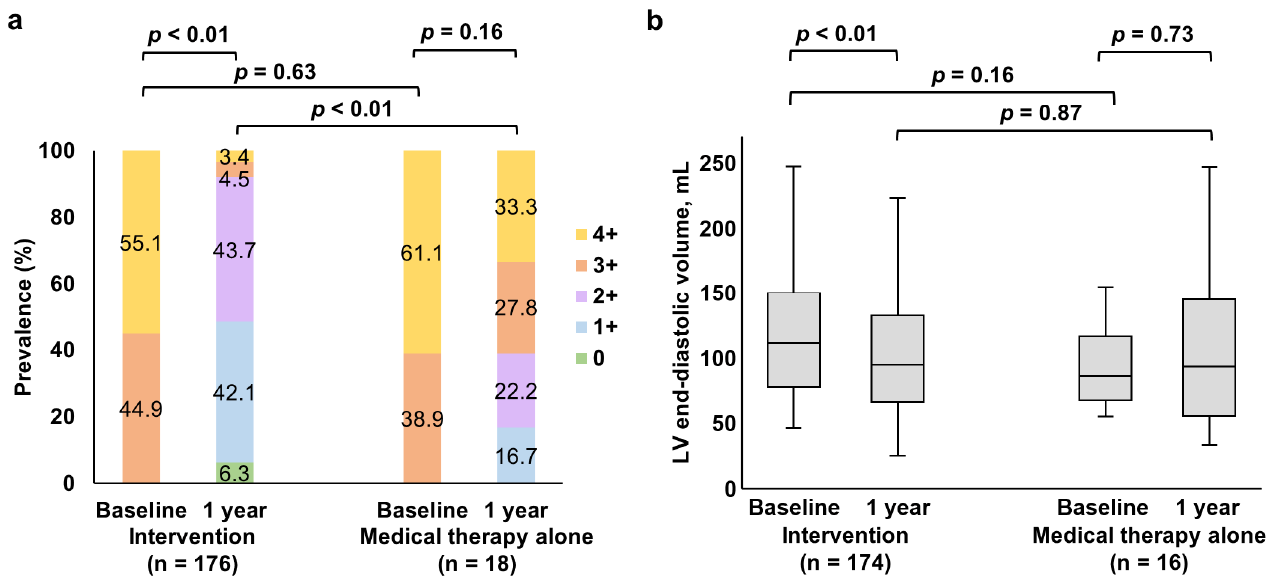
Figure 9. Changes in severity of MR and LV end-diastolic volume. At one year, patients undergoing mitral valve interventions had a lower severity of MR compared to medical therapy alone ( p < 0.01) ( a ). Mitral valve intervention was associated with decreased LV end-diastolic volume from baseline to one-year follow-up ( p < 0.01). LV end-diastolic volume within one year follow-up was similar between the two groups (94.9 mL [66.3, 132.3] vs. 93.3 mL [55.6, 144.7], p = 0.87) ( b ). Abbreviations: LV, left ventricular and MR, mitral